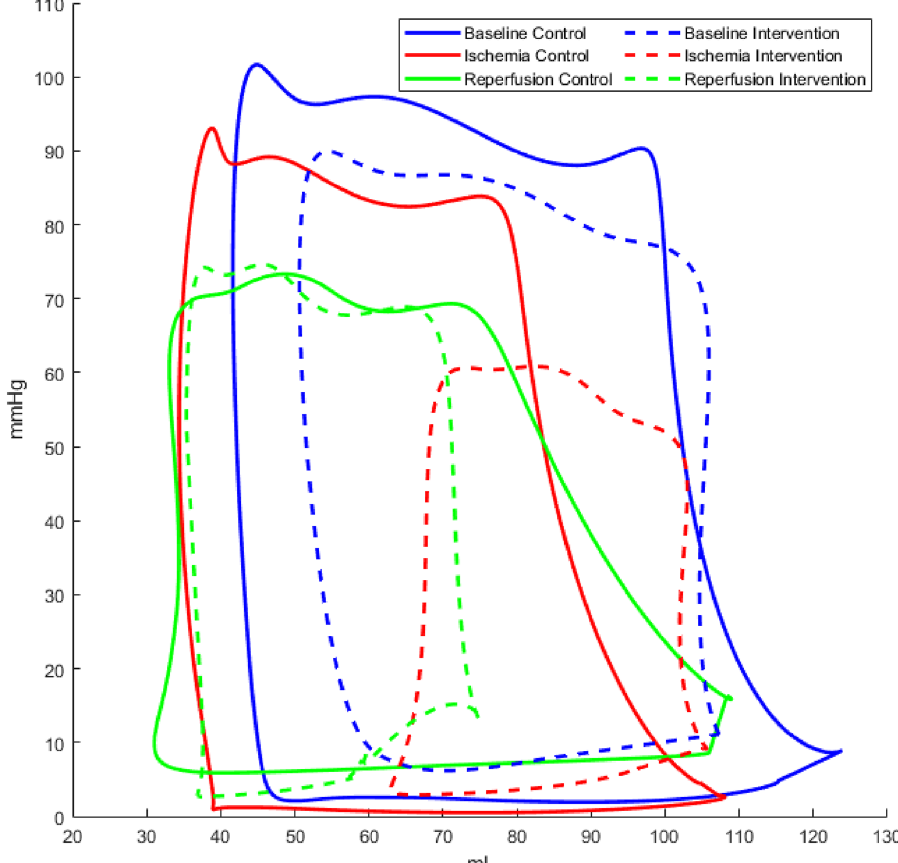
Figure 1. Representative pressure–volume loops from control (solid loops) and intervention (dotted loops) group at baseline, during ischemia, and after